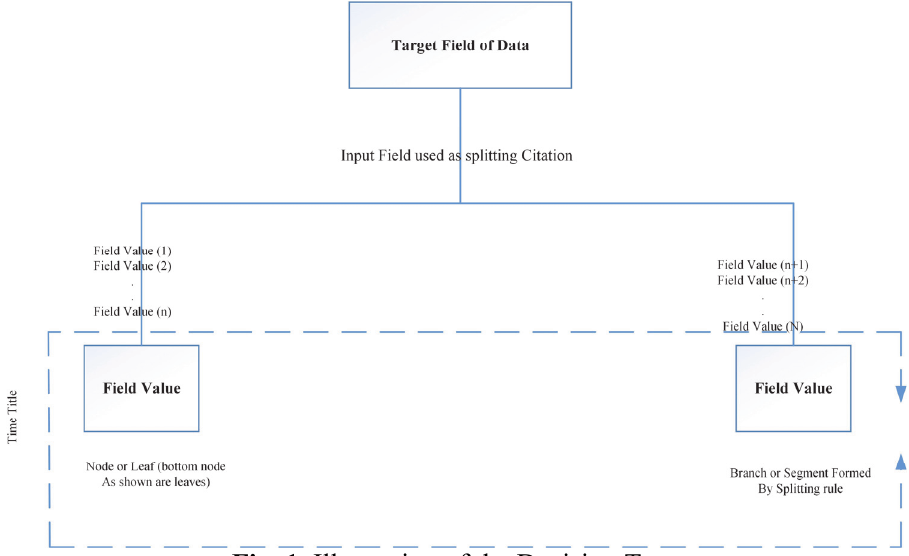
Fig. 1 . Illustration of the Decision